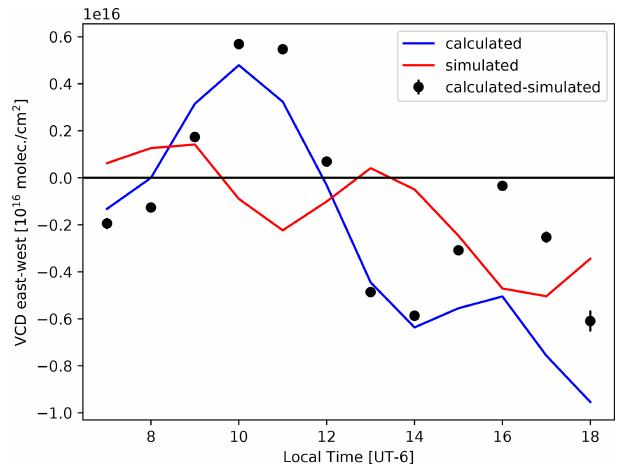
Figure 9. Average differences between the retrieved columns us- ing the east and west measurement sides, as function of the hour of the day, are presented in the blue line. The red line simulates how the information available from the retrievals would produce a dif- ference in the columns, assuming that the retrieval of the V3 dataset using both measurement sides best describes the atmospheric state (see text for details). The black points are the difference between the found differences and the “forecasted” differences and should show the part of the difference which might be related to a real in- homogeneity and a gradient between the east and the west HCHO concentrations in the mixing layer. The error bars represent the stan- dard error and show that the measurement amount is large enough to calculate a statistically significant mean difference for each day by hour, and the grouping for different hours is